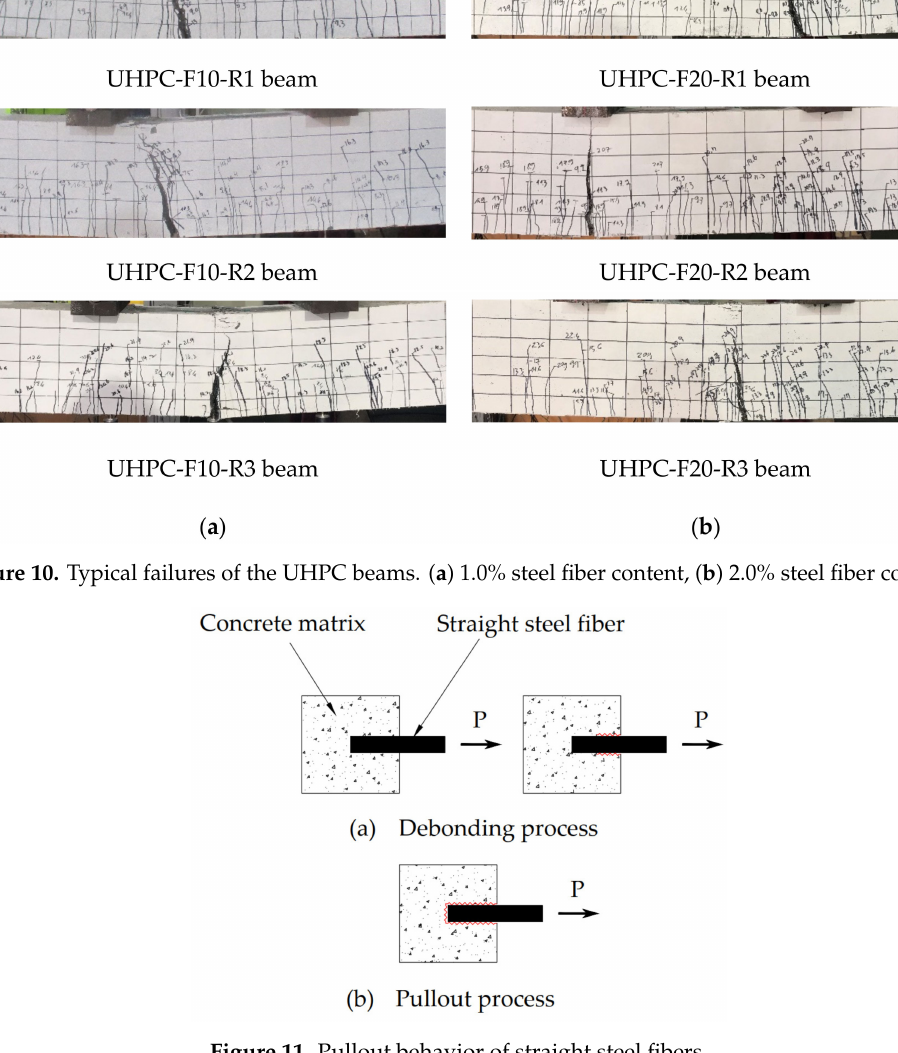
Figure 11. Pullout behavior of straight steel